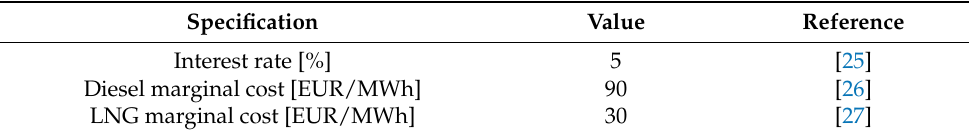
Table 4. General economic parameters.